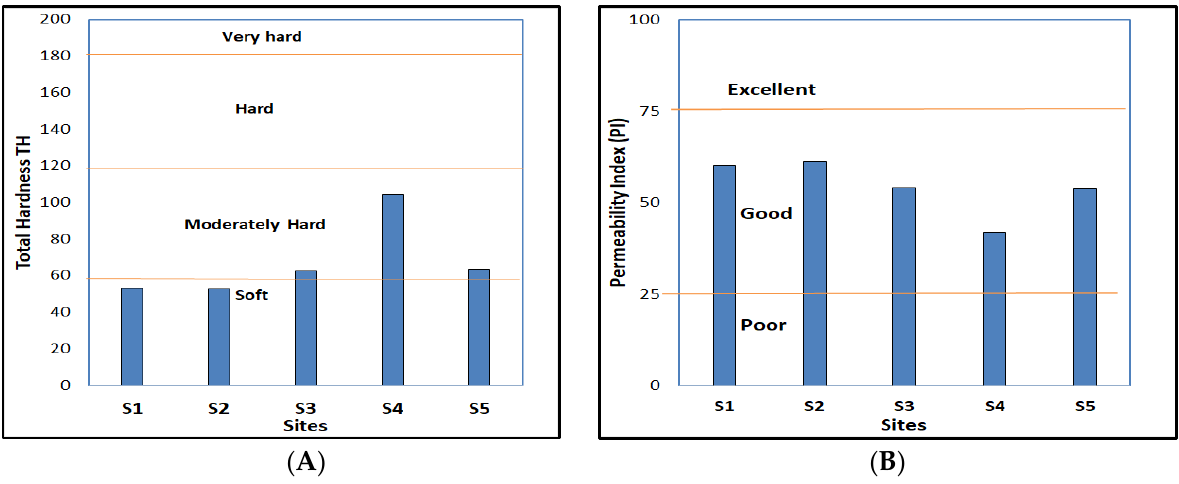
Figure 9. Total hardness and permeability for the groundwater samples. ( A ). Total hardness (TH) < 60, soft; 61 – 120, moderately hard; ( B ). Permeability (PI) 25 – 75, good.